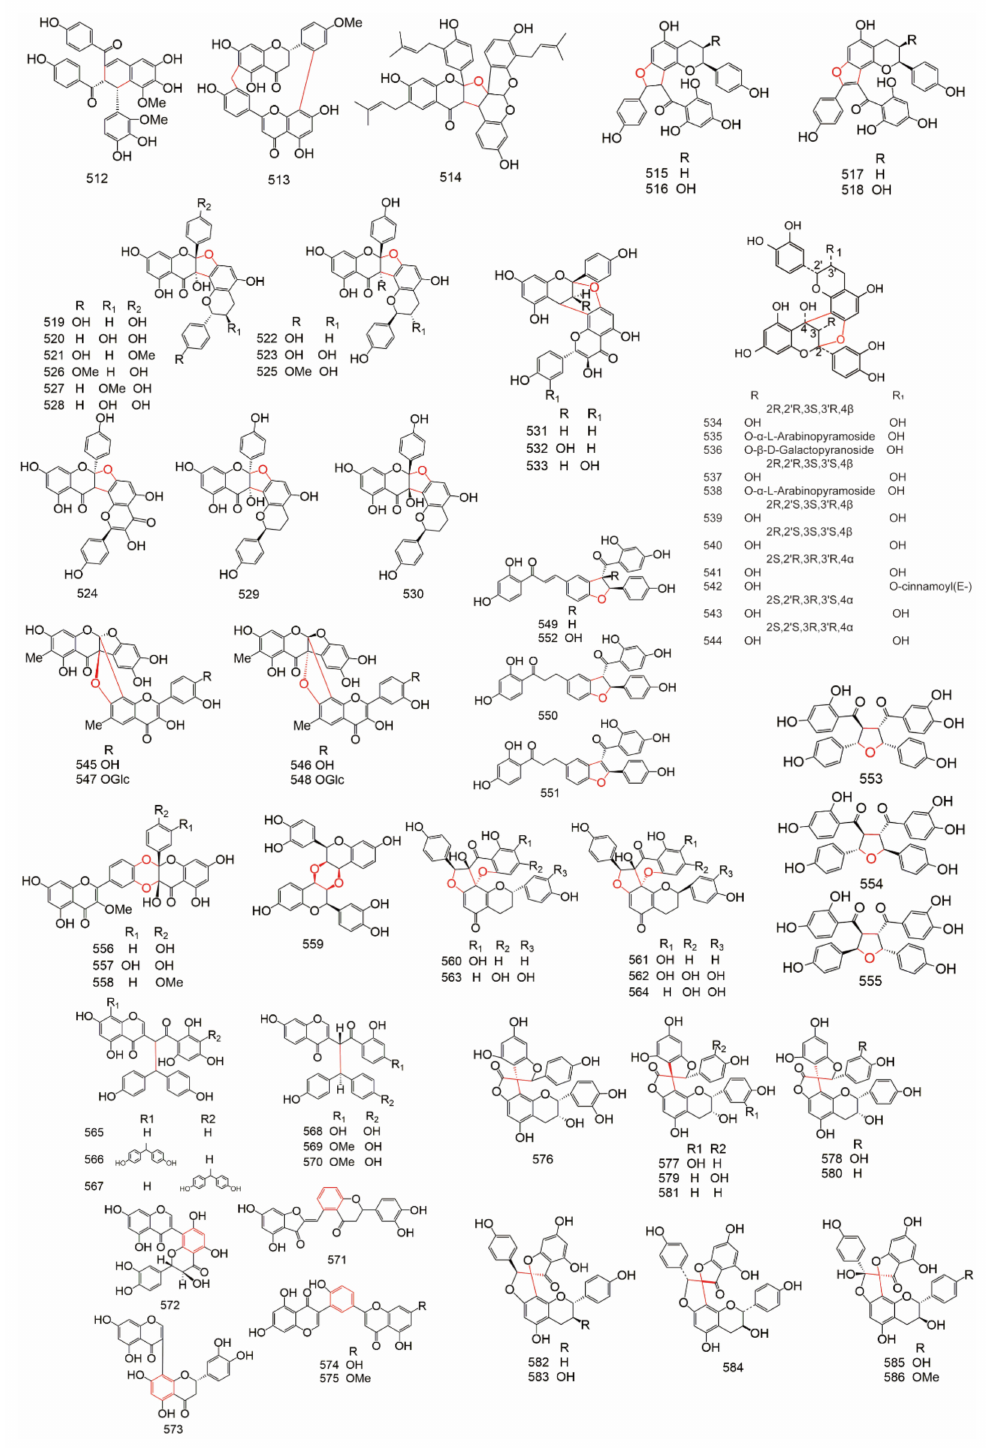
Figure 11. The structure of Complex